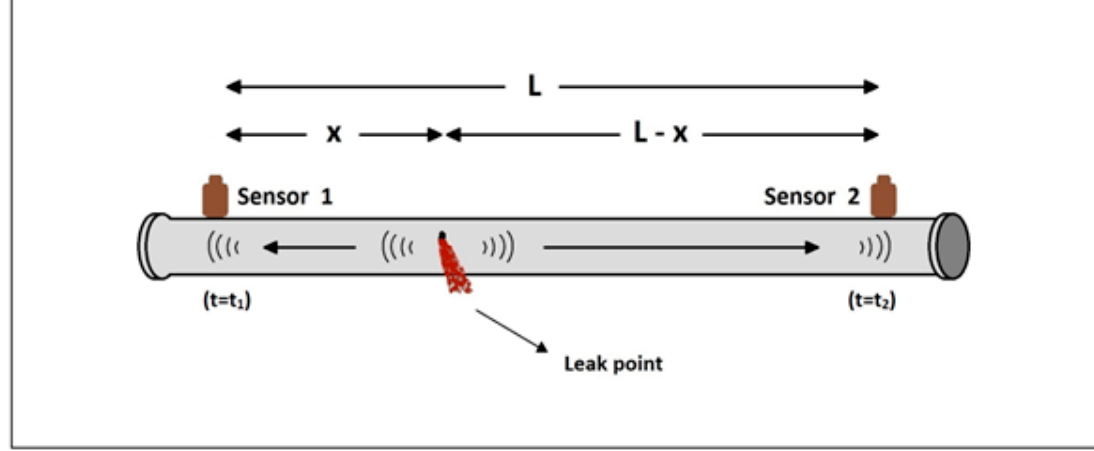
Figure 1. Acoustic waves propagating in the pipeline.